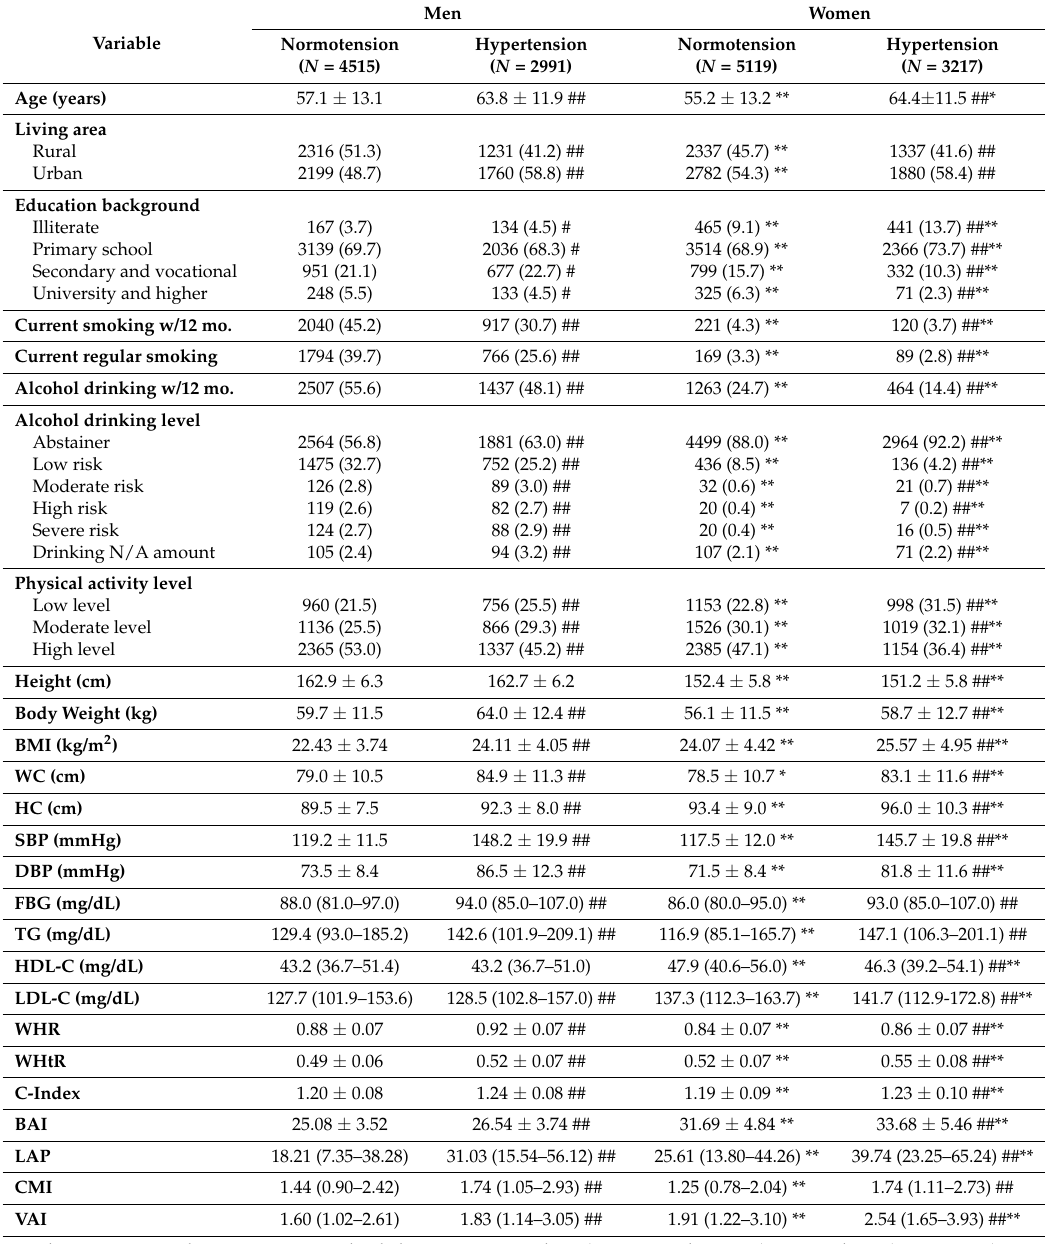
Table 1. Anthropometric and biochemical characteristics of the study